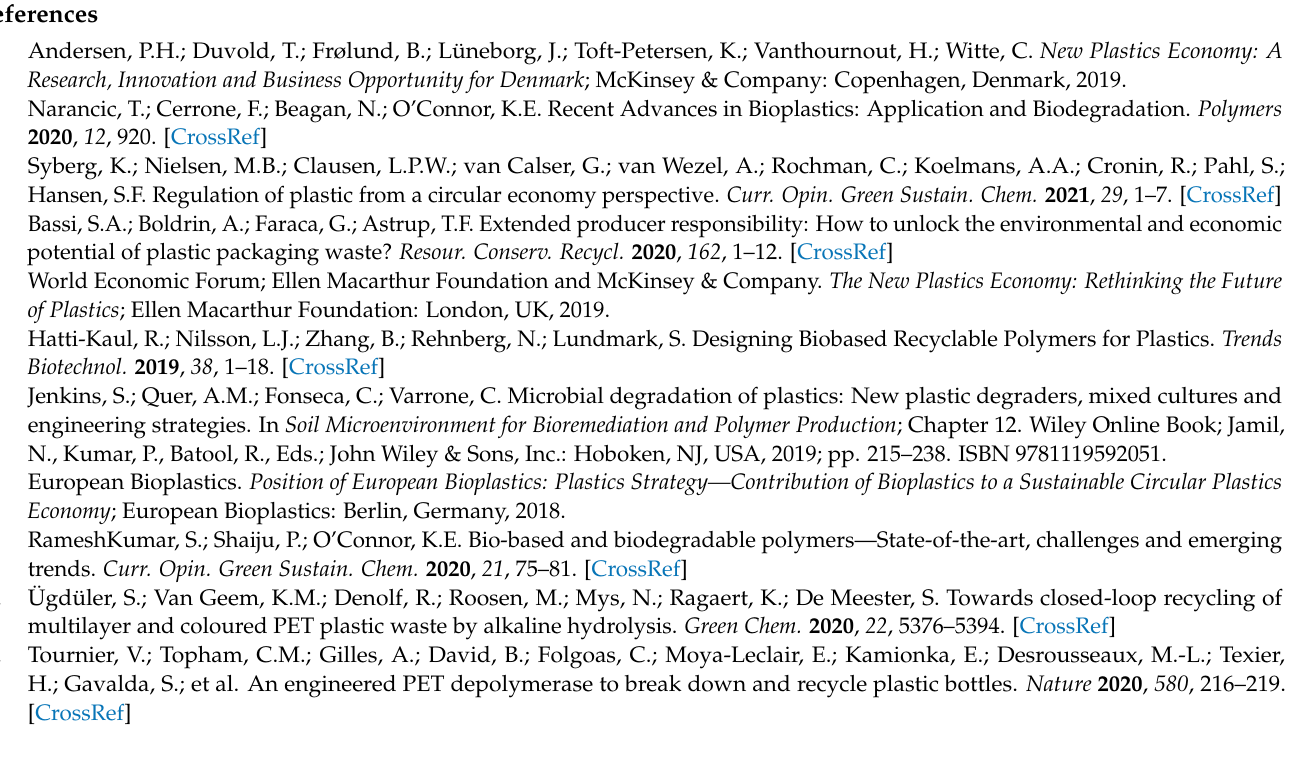
Figure S1c: Process flow diagram of Area 3; Figure S1d: Process flow diagram of Area 4; Figure S1e: Process flow diagram of Area